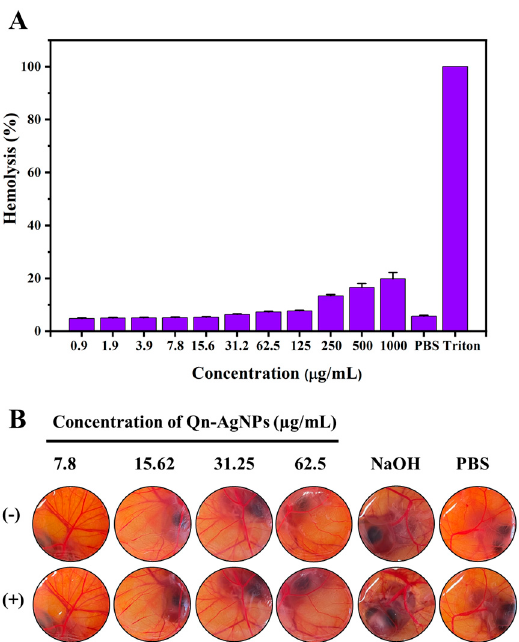
Figure 7. Hemolysis effect of Qn-AgNPs ( A ); and Chick chorioallantoic membrane (CAM) assay of different concentration of Qn-AgNPs ( B ). ( − ) before treatment, (+) after treatment.